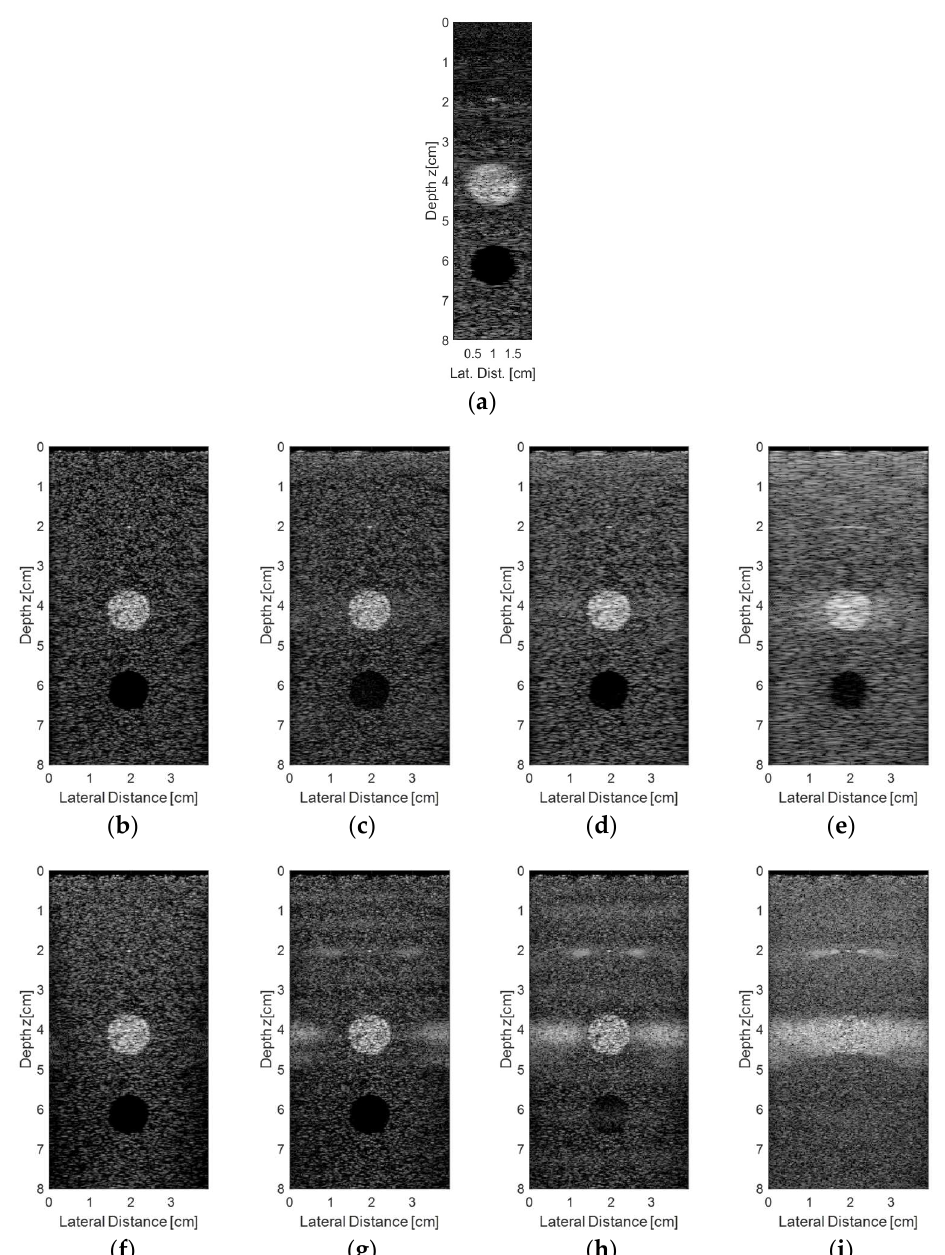
Figure 10. Simulated results for the raw rf signals acquired from the synthetic phantom by a linear 128 element transducer and processed with DAS and Stolt migration algorithms: ( a ) DAS, aperture of 64 elements, focal length at 2 cm; ( b – e ) Plane wave excitation with angles ranging from −1.5° to +1.5° (0.5° step) and the reception with ( b ) 128, ( c ) 65, ( d ) 44, and ( e ) 23 active elements; ( f – i ) Plane wave excitation with angles ranging from −15° to +15° (5.0° step) and reception with ( f ) 128, ( g ) 65, ( h ) 44, and ( i ) 23 active elements.